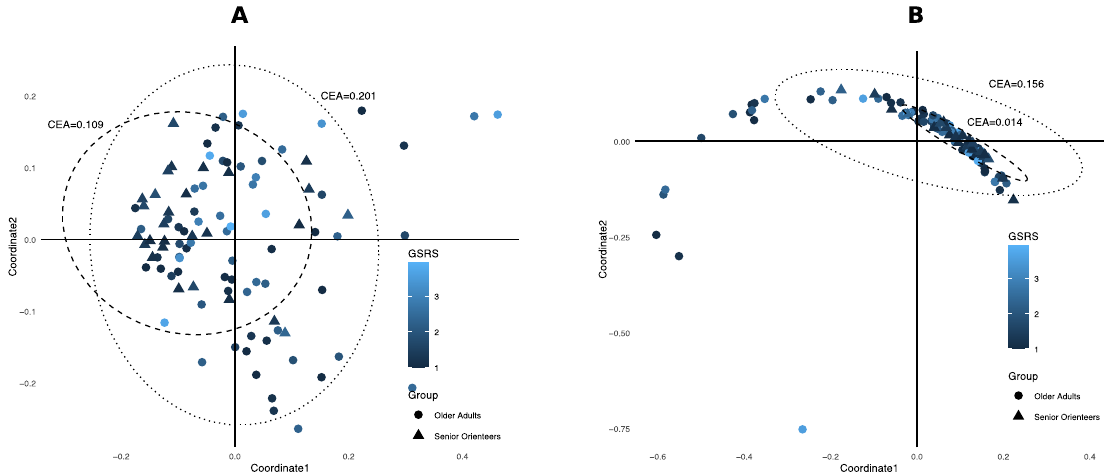
Figure 7. Principal coordinates analysis (PCoA) plots. Principal coordinates were estimated using Bray–Curtis distance on the predicted species. Each dot represents an individual sample, shape depicts groups, and blue scale codes for the gastrointestinal symptom scores measured with Gastrointestinal Symptom Rating Scale (GSRS) values. Dotted ellipse indicates 95% confidence region of older adults and dashed ellipse indicates 95% confidence region of senior orienteers. CEA = 95% confidence ellipse area. ( A ) PCoA using all predicted species; ( B ) PCoA using four selected species that were significantly di ff erent between older adults and senior orienteers.